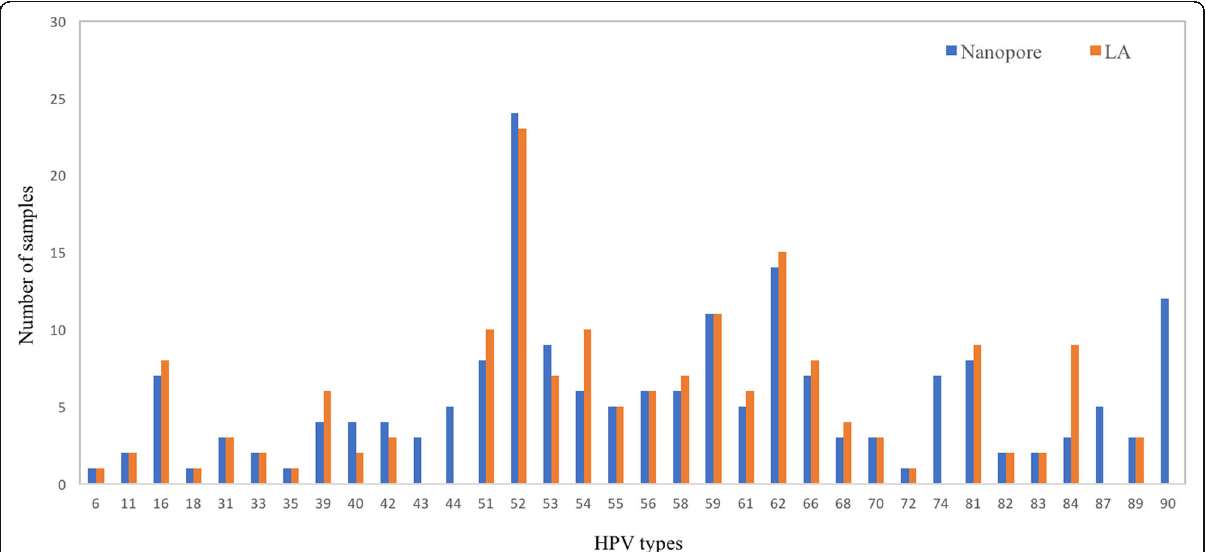
Fig. 2 Diversity of HPV types detected by Nanopore workflow and